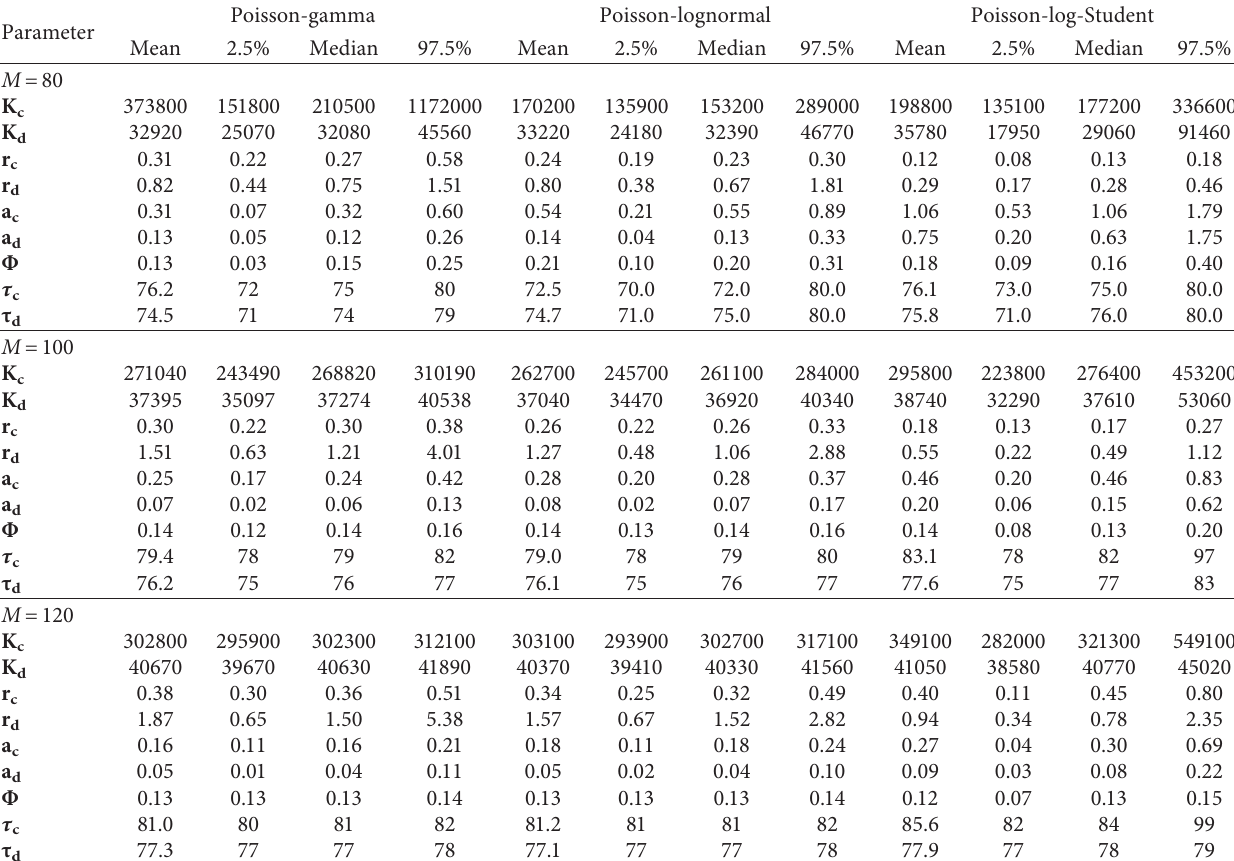
Table 1: Estimations according to timing of cross-validation period ( M is days after start of epidemic).